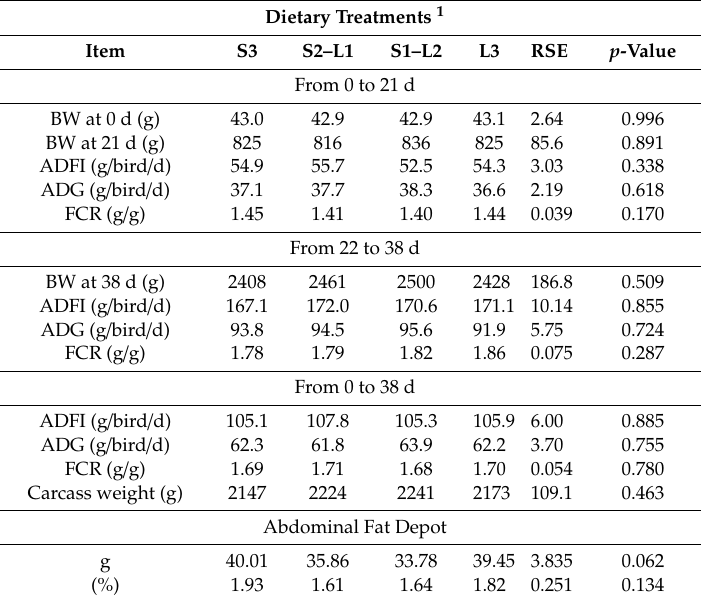
Table 5. Growth performance and abdominal fat pad deposition of broiler chickens according to di ff erent dietary added fats (Experiment